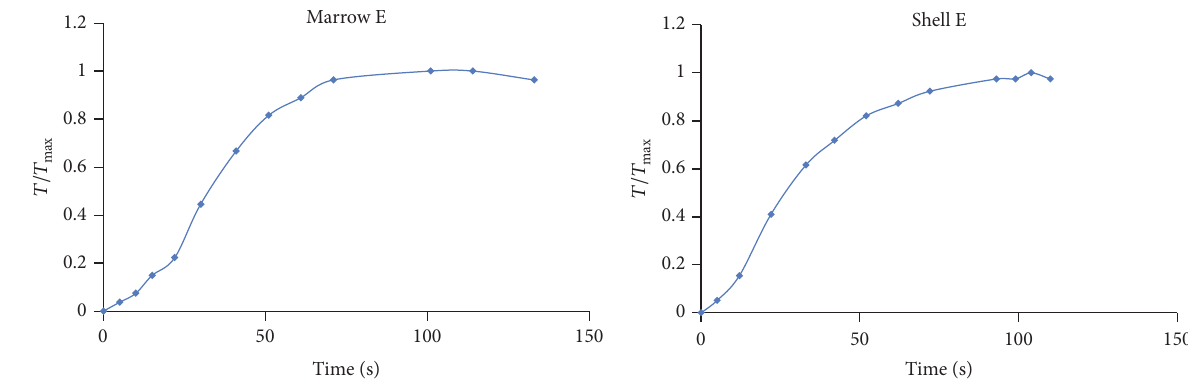
Figure 10: Curve 𝑇 / 𝑇 max with respect to time of the analytical model of Parker and